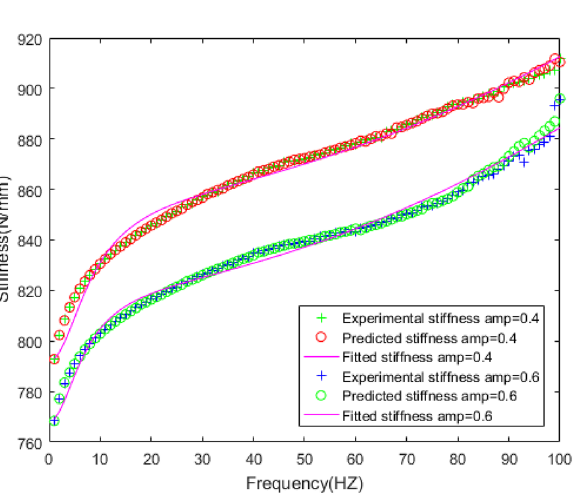
Figure 23. Fitting the curve of dynamic stiffness with five-parameter mathematical model under amplitude 0.4 mm, 0.6